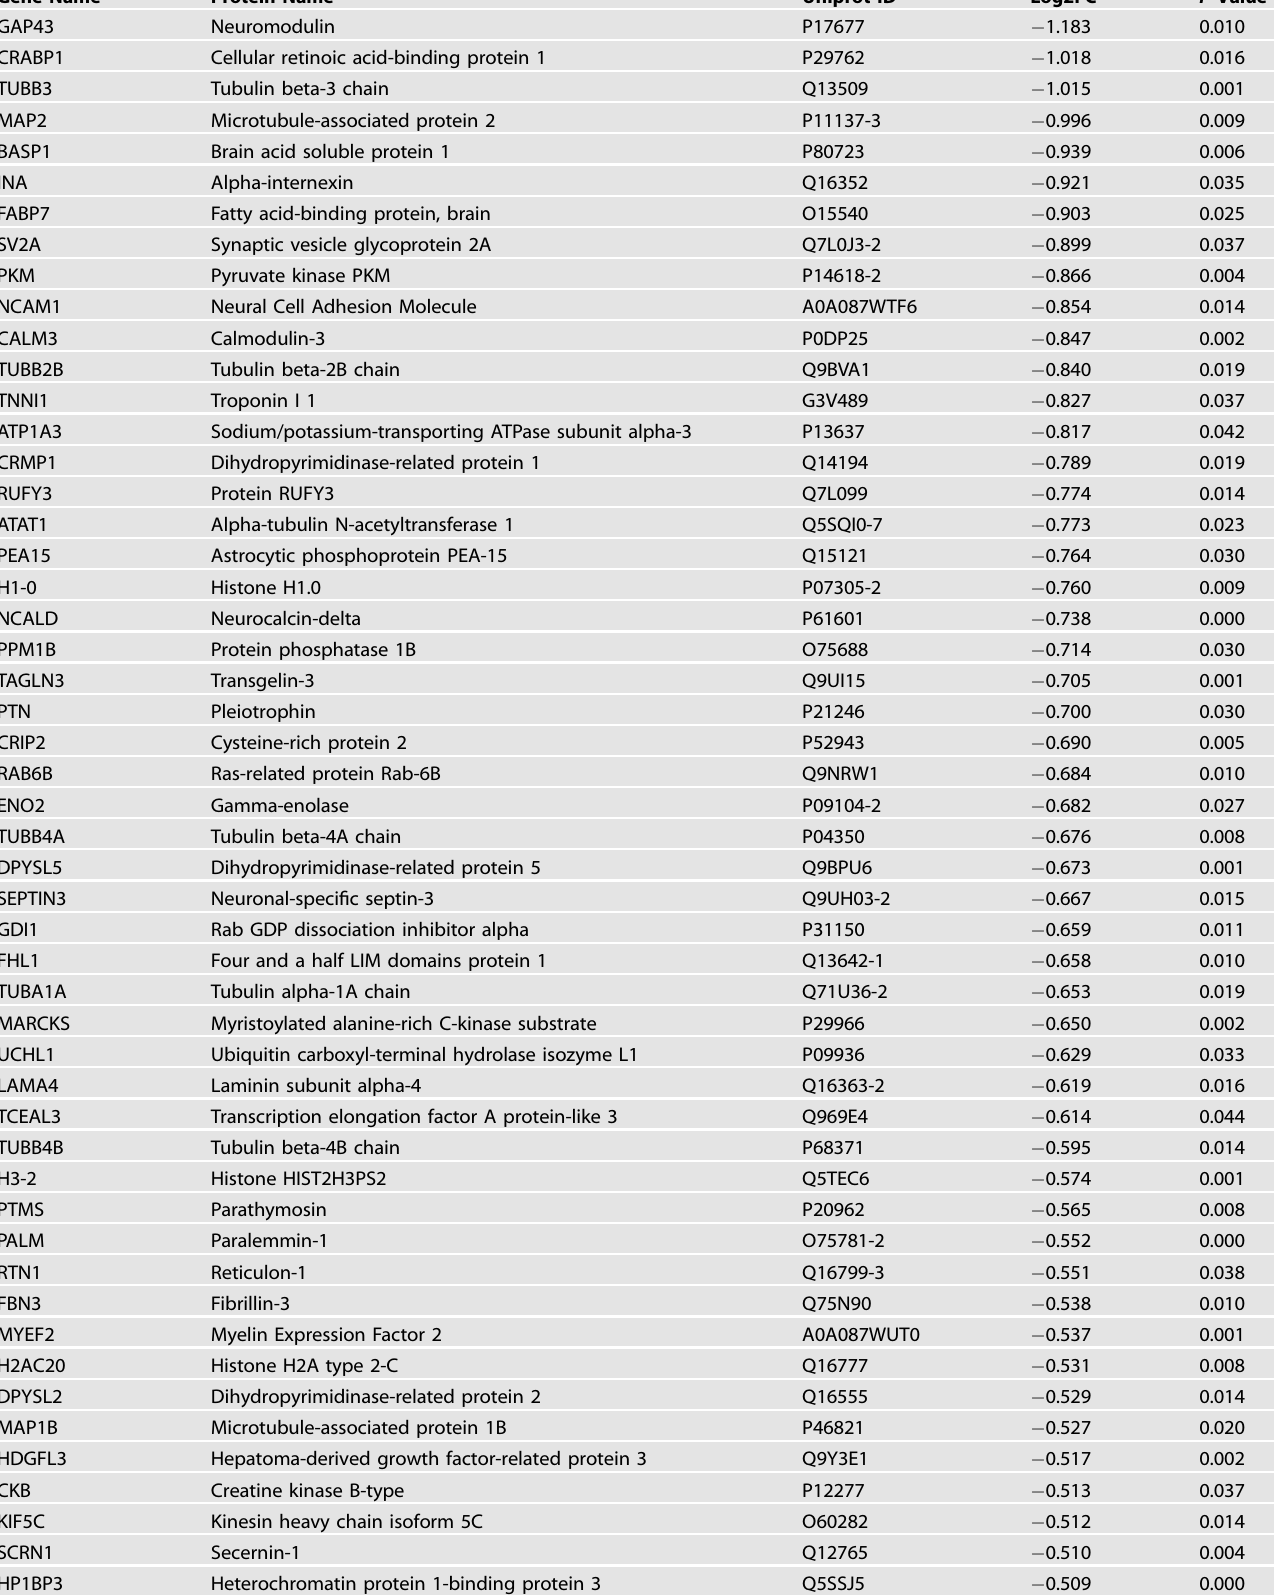
Table 1. 54 Down-regulated proteins in Scz organoids (< − 0.5 Log2FC, p <